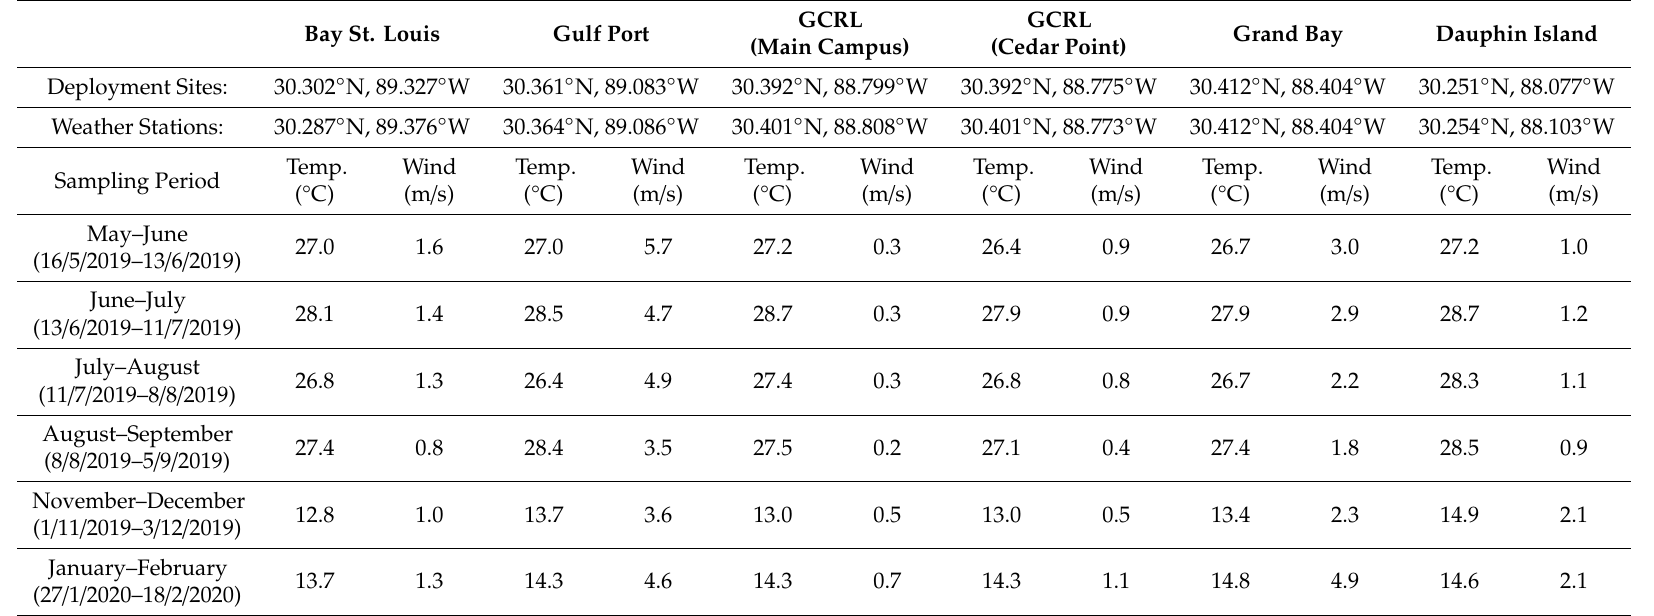
Table A1. Coordinates for sampling sites and nearest weather stations, along with sampling periods and mean temperature and wind speed during deployment. Bay St.